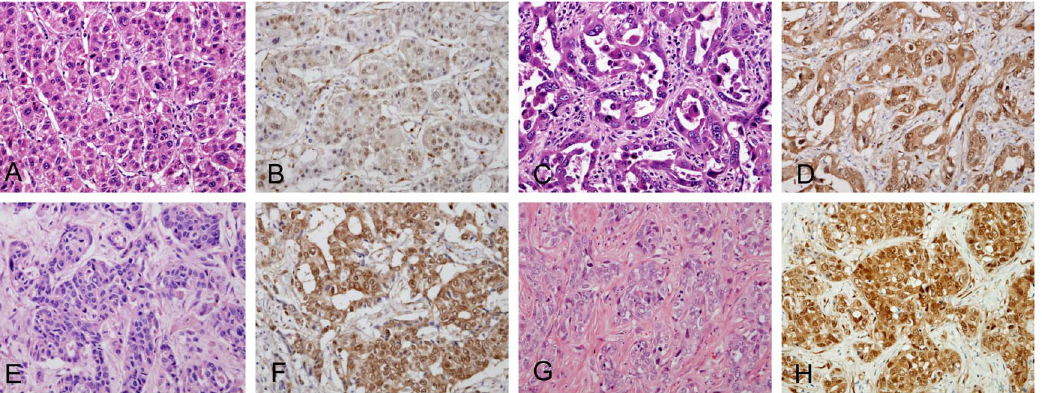
Figure 2. YAP1 expression in combined hepatocellular cholangiocarcinoma (cHC-CC). (A-F) Pathological features and YAP1 expression are shown in each component of classical type combined hepatocellular cholangiocarcinoma, including a hepatocellular carcinoma (HCC) area (A, B), a cholangiocarcinoma (CC) area (C, D), and a transitional zone (E, F). YAP1 expression is evident in the nuclei of tumor cells in CC areas (D) and transitional zones (F) in contrast to weak nulcear YAP1 expression in HCC areas (B). (G-H) Intermediate subtype of cHC-CC with stem cell features showing strong nuclear YAP1 expression. (Original magnification, 6 200). doi:10.1371/journal.pone.0075449.g002 PLOS ONE |